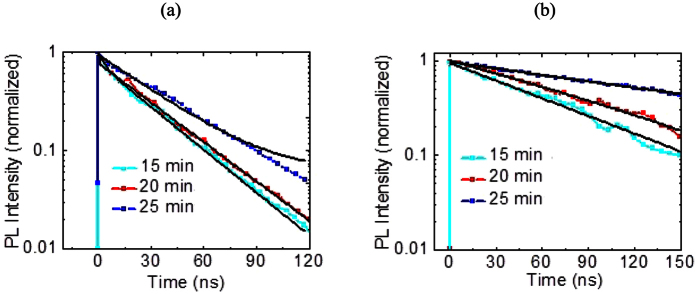
PL decay curves of MAxFA1−xPbI3 at different growth times from 5 to 25 min for (a) 10, and (b) 400 sccm H2 flow rates upon excitation at 517 nm, 90 nJ/cm2.